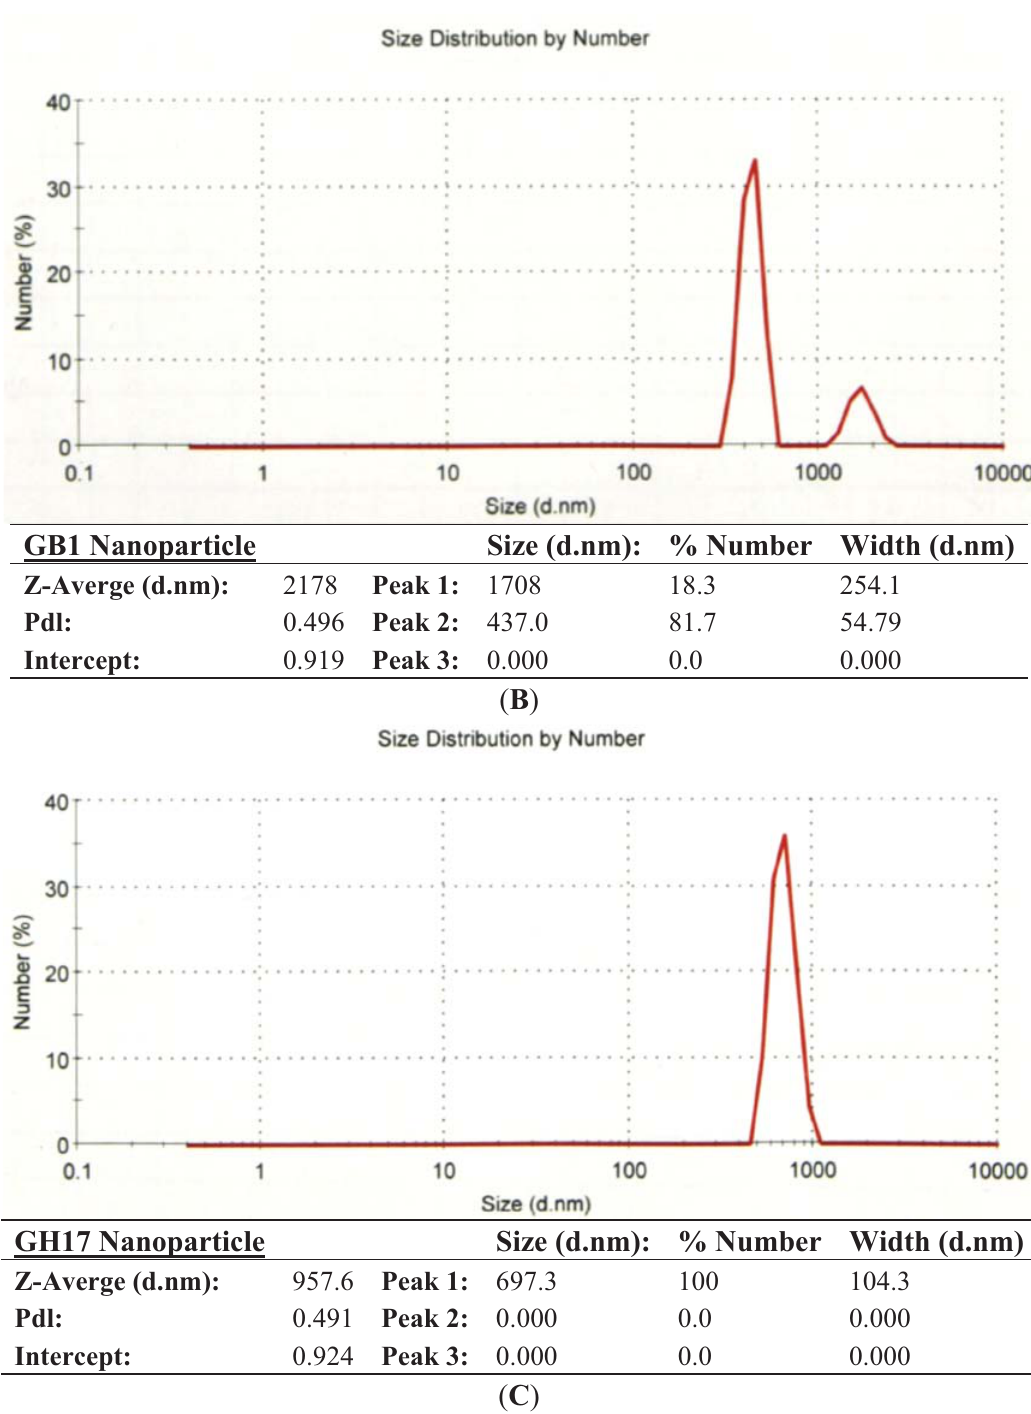
Figure A1. Dispersity of the nanoparticle vaccines monitored by dynamic light scattering (DLS). ( A ) GA2 nanoparticle; ( B ) GB1 nanoparticle; ( C ) GCH17 nanoparticle. Stepwise LbL steadily increases the diameter of the particles several fold, from an apparent diameter of about 150 nm for uncoated particles to about 400–600 nm for fully coated particles. Some particle aggregation was detected in each batch ( A and B ) with a second population of particles in the 1500–2000 nm